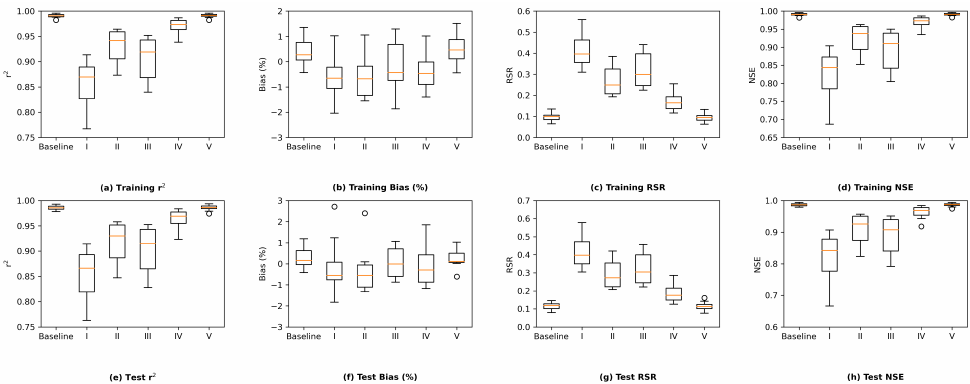
Figure A8. Box and whisker plots of four types of metrics consisting of r 2 , percent bias, RSR, and NSE on stations belonging to the western Delta group during the training (panels ( a – d )) and test (panels ( e – h )) phases of the grouped (G) MLP model under five scenarios: baseline and four different memory lengths as presented in Table